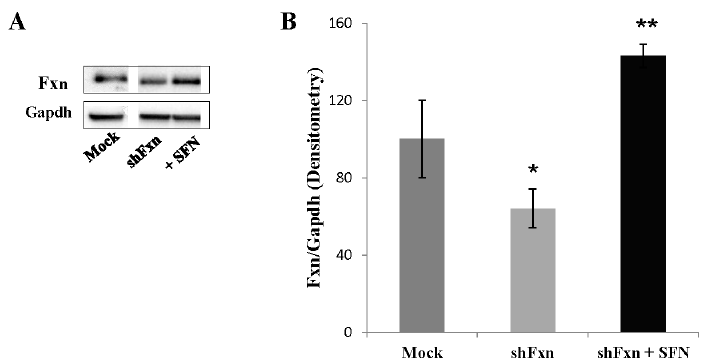
Figure 5. The amount of frataxin increases after SFN treatment. ( A ) Representative Western blot of shFxn incubated for 24 h with 5 µM SFN; ( B ) Densitometry of blots normalized to GAPDH. Values represent the mean ± SD of three independent experiments (* p < 0.05, ** p < 0.01, with respect to untreated shFxn).